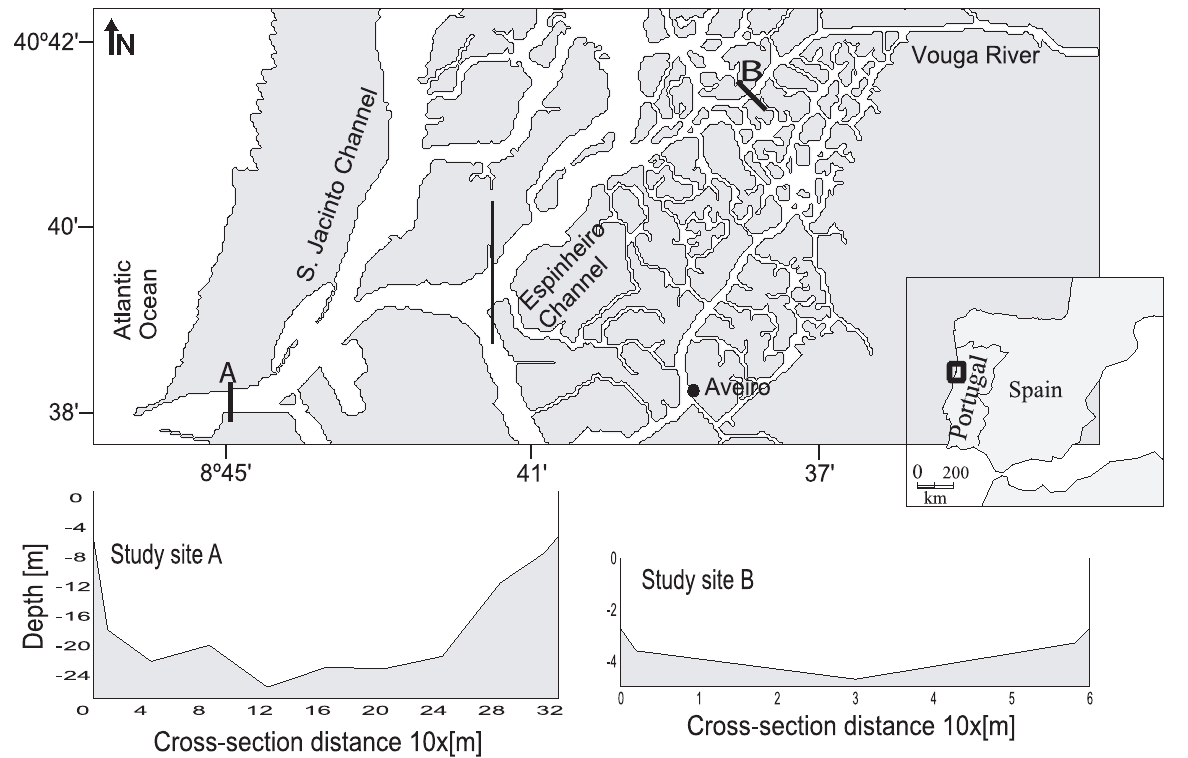
Figure 1. The Espinheiro channel showing the survey locations A and B.